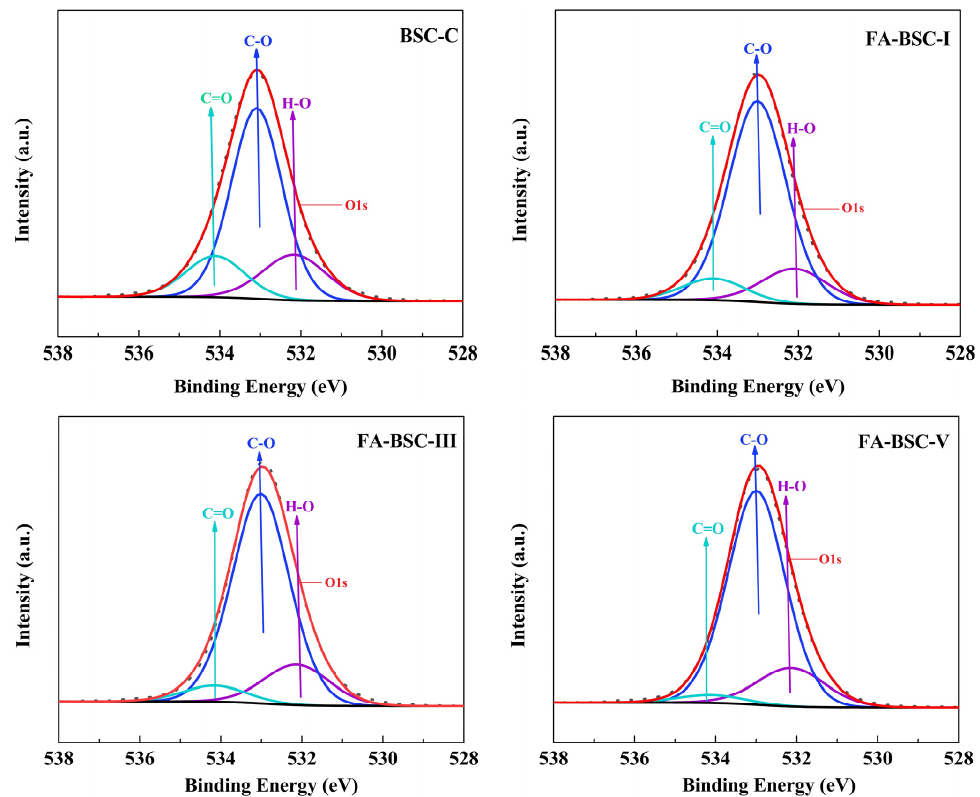
Figure 6. XPS spectra of O peaks in untreated and furfurylated